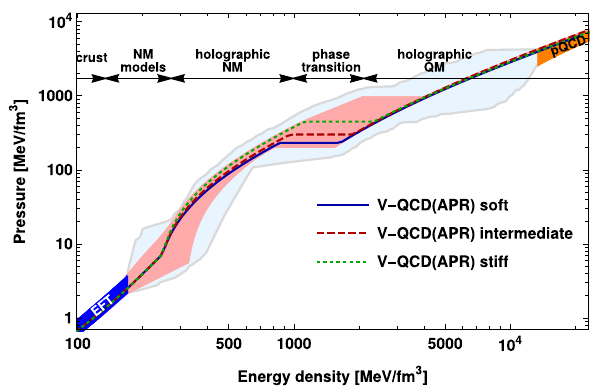
Fig. 15 Predictions of the hybrid EOS setup. The light blue band is spanned by all interpolating EOSs satisfying the astrophysical bounds, and the light red band is spanned by the hybrid V-QCD EOSs satis- fying the same bounds. The curves show the three variants of the V- QCD(APR) EOSs as indicated by the legend. The horizontal lines with arrows show roughly the different regimes of the hybrid EOSs